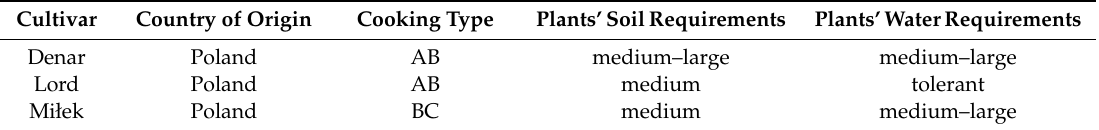
Table 3. Characteristics of potato cultivars